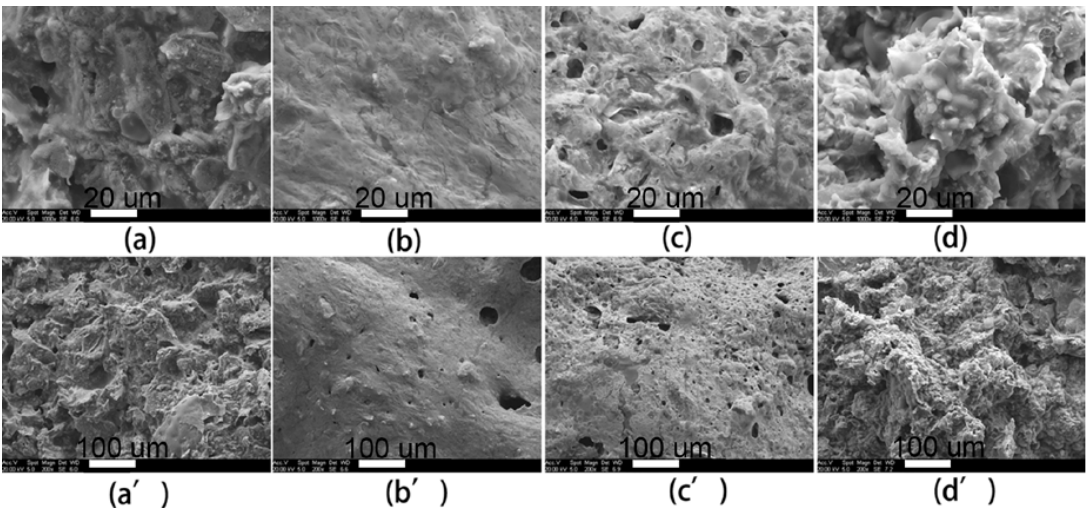
Figure 7. SEM images with 1000× (( a – d )) and 200× (( a′ – d′ )) of the residues after cone calorimeter tests. ( a ) and ( a′ ) ELDH - 0; ( b ) and ( b′ ) ELDH - Ni; ( c ) and ( c′ ) ELDH - Co; ( d ) and ( d′ ) ELDH - Cu.